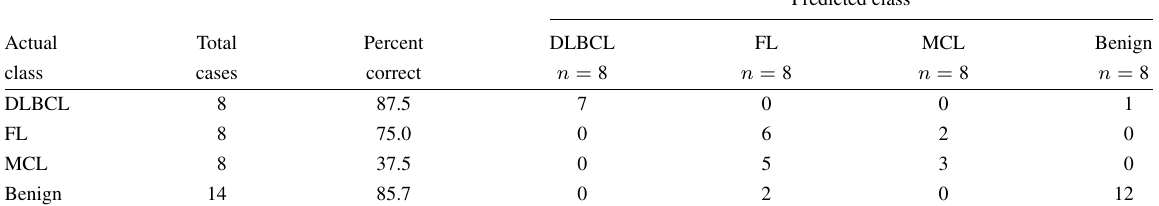
B: predicted classification after V-fold cross-validation.